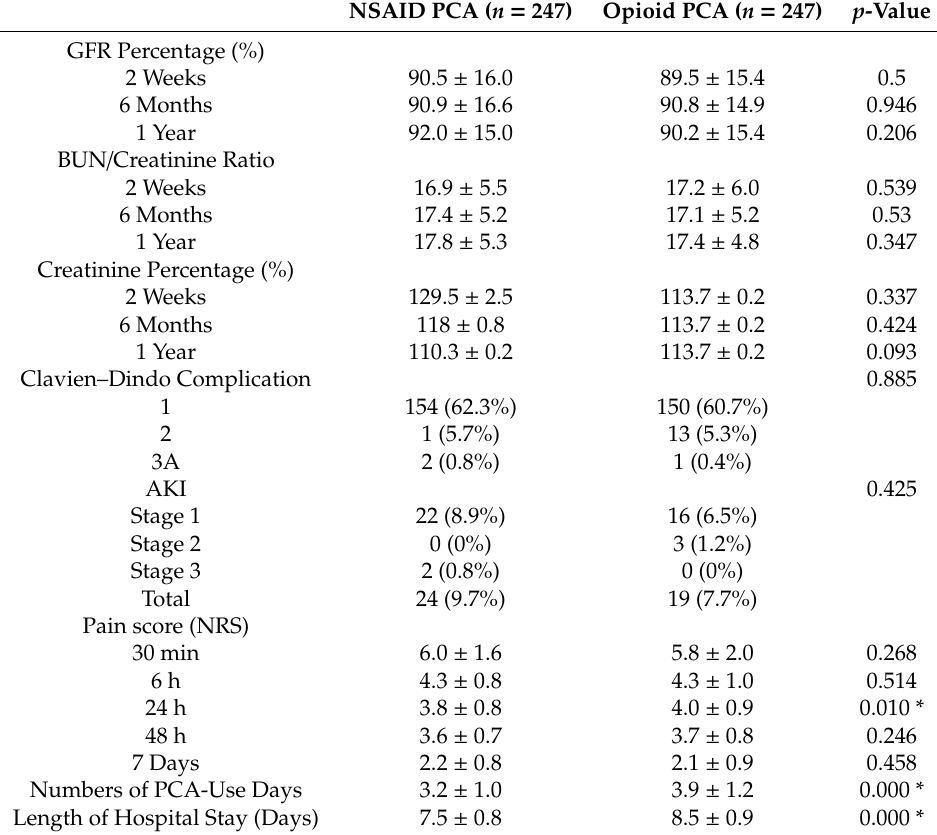
Table 3. Postoperative renal function and postoperative